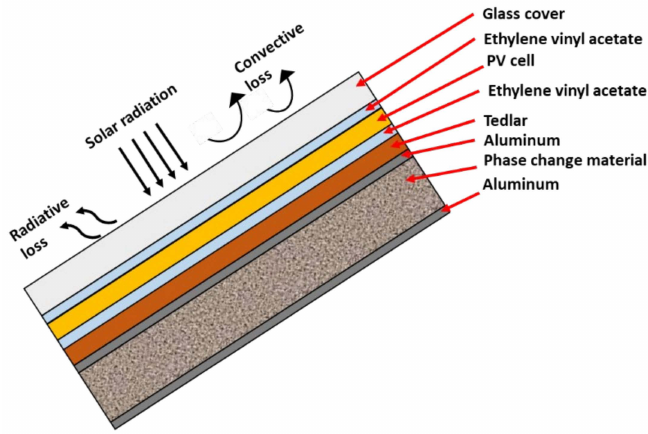
Figure 5. Integrated PV-PCM system.